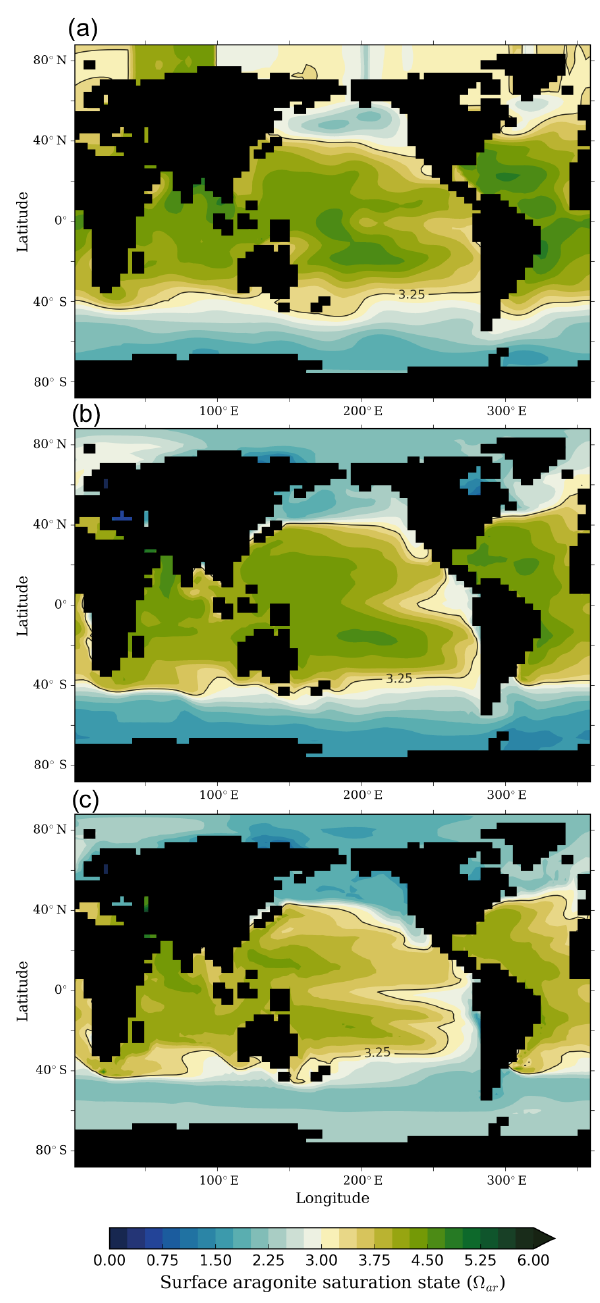
Figure 7. The annual average surface aragonite saturation state ( (cid:127) ar ) calculated from (a) the observations of Key et al. (2004), (b) the O-PI experiment and (c) the O-LGM experiment.